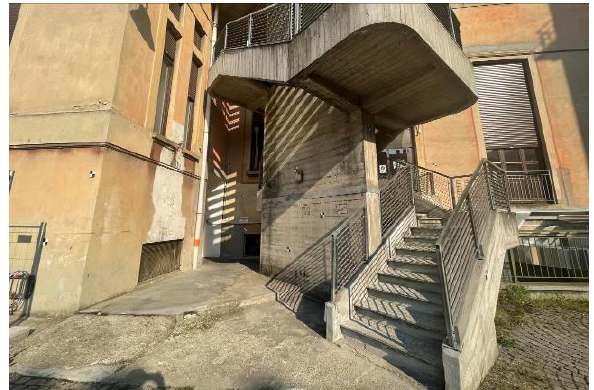
Figure 2 . Photo of the test area.